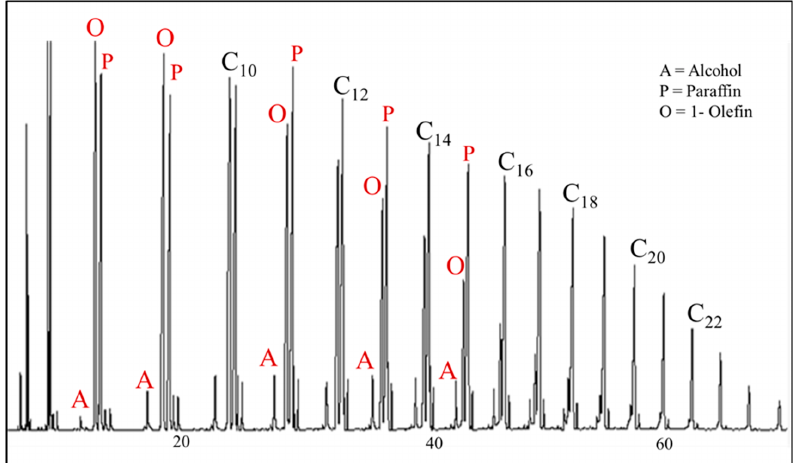
Figure 18. A chromatographic picture of a titania supported ruthenium catalyst. The x-axis is retention time in minutes. Reaction Conditions: 220 °C, 19.3 bar, WHSV = 3, and H 2 /CO = 2. Catalysts 201 9 , 8 , x FOR PEER REVIEW 20 of 61